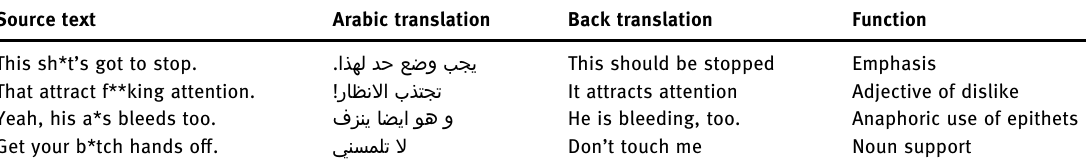
Table 12: Slot fi ller –